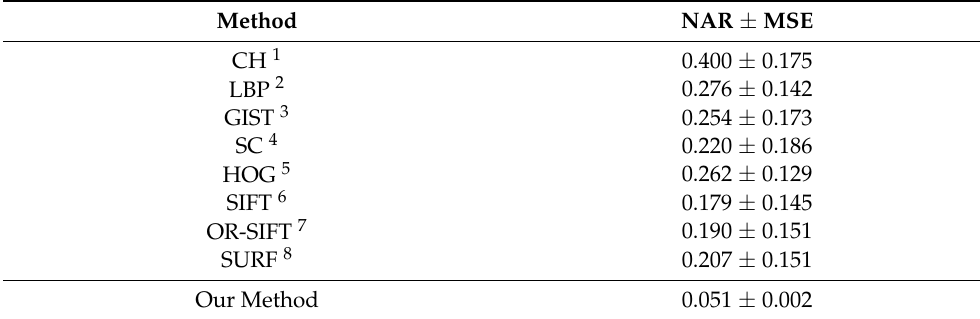
Table 1. Comparison results with traditional trademark retrieval methods.